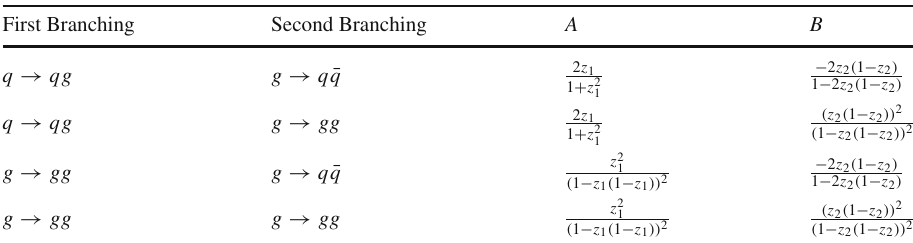
Table 1 The coefficients A and B for the correlation between the azimuthal angles of the first and second branching. The momentum fraction in the first branching is z 1 and z 2 in the second branching